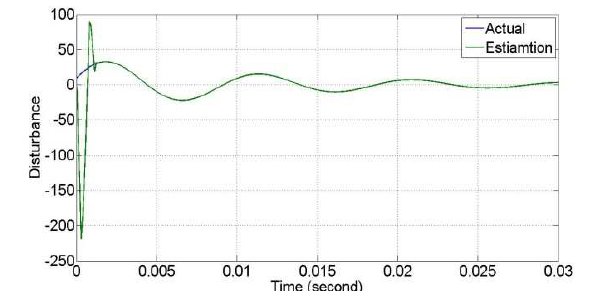
Fig. 5. Open loop estimation under Fig. 8. Open loop piston acceleration parametric uncertainties. under parametric uncertainties. ¢ (cid:159) = (cid:160). (cid:158) (cid:159) = (cid:160). £ In order to prove the estimator robustness and the powerful of the HOSMO, the open loop simulation is repeated with . The estimation performance does not changed in spite α = 0.3 of increasing the uncertainty percent as can be deduced from figure (6) to figure (9). α